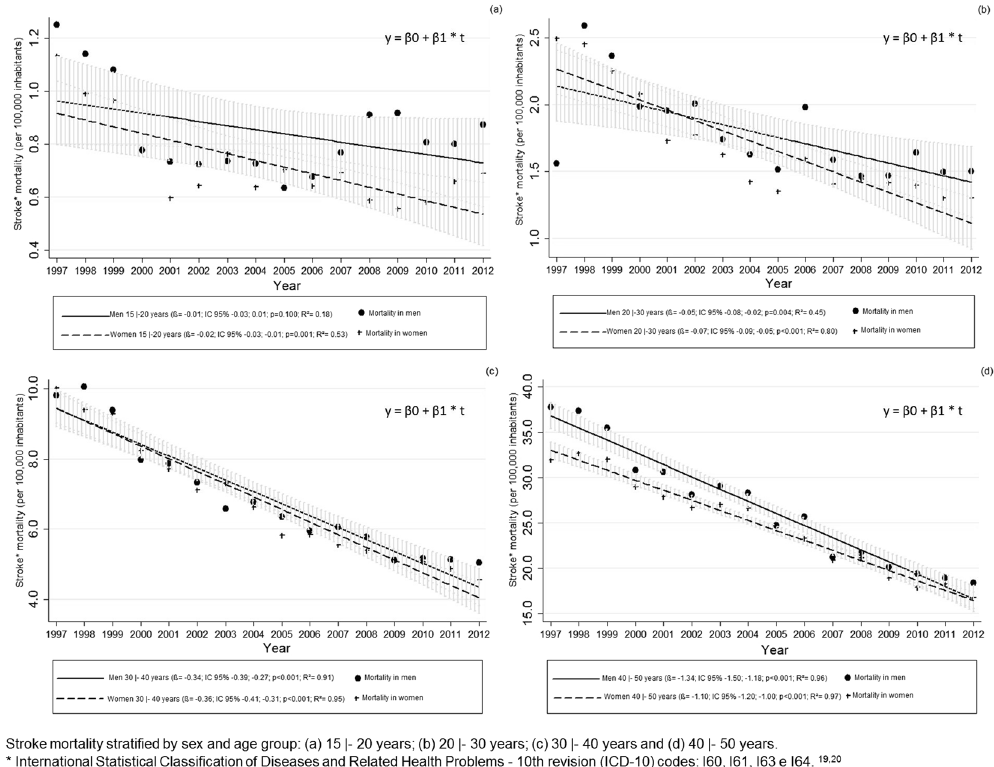
Figure 2. Time trends in stroke mortality according to sex and age group in Brazilian adults between 1997 and